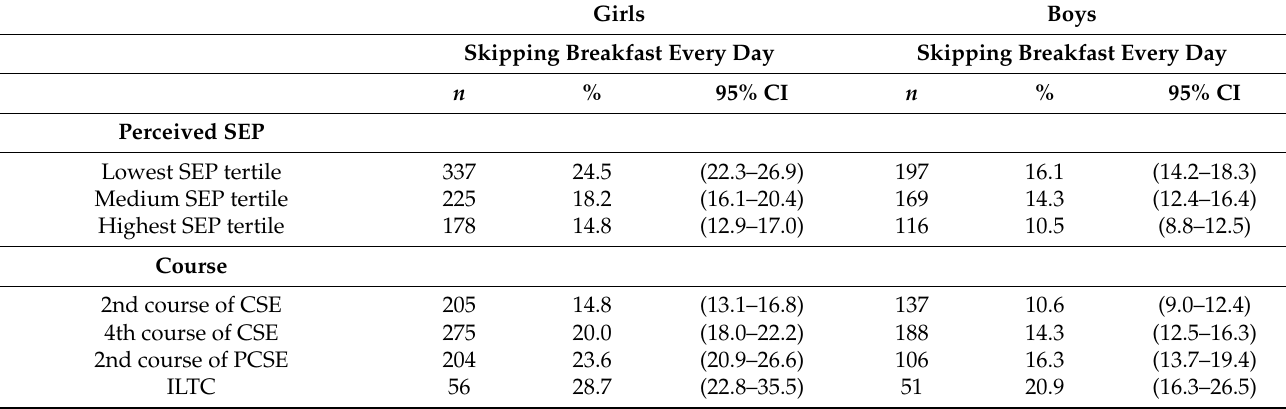
Table 2. Prevalence of skipping breakfast every day in the last week for each of the independent